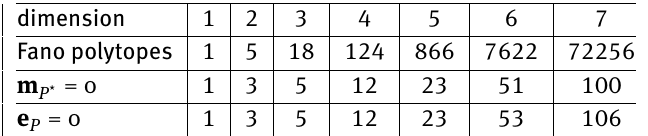
Table 1: The number of Fano